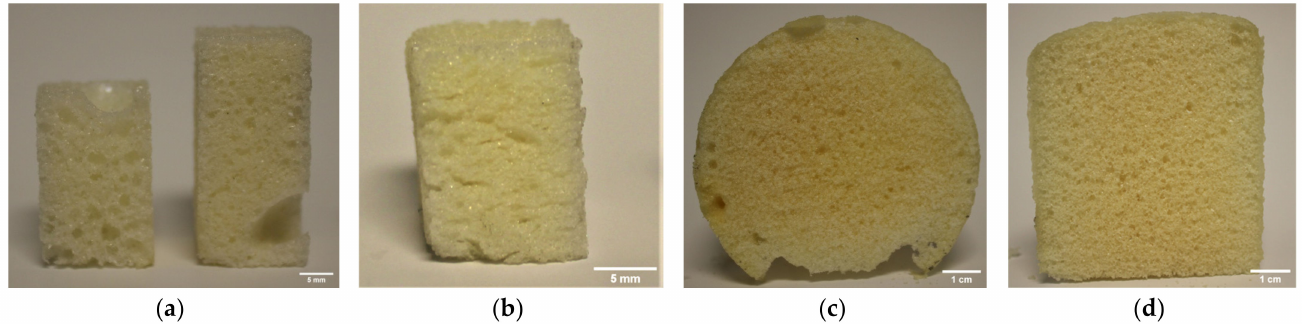
Figure 2. Polymeric foam product with ( a ) coarsening due to early addition of foaming agent, ( b ) cracking due to too late addition of foaming agent, ( c , d ) optimized addition of foaming